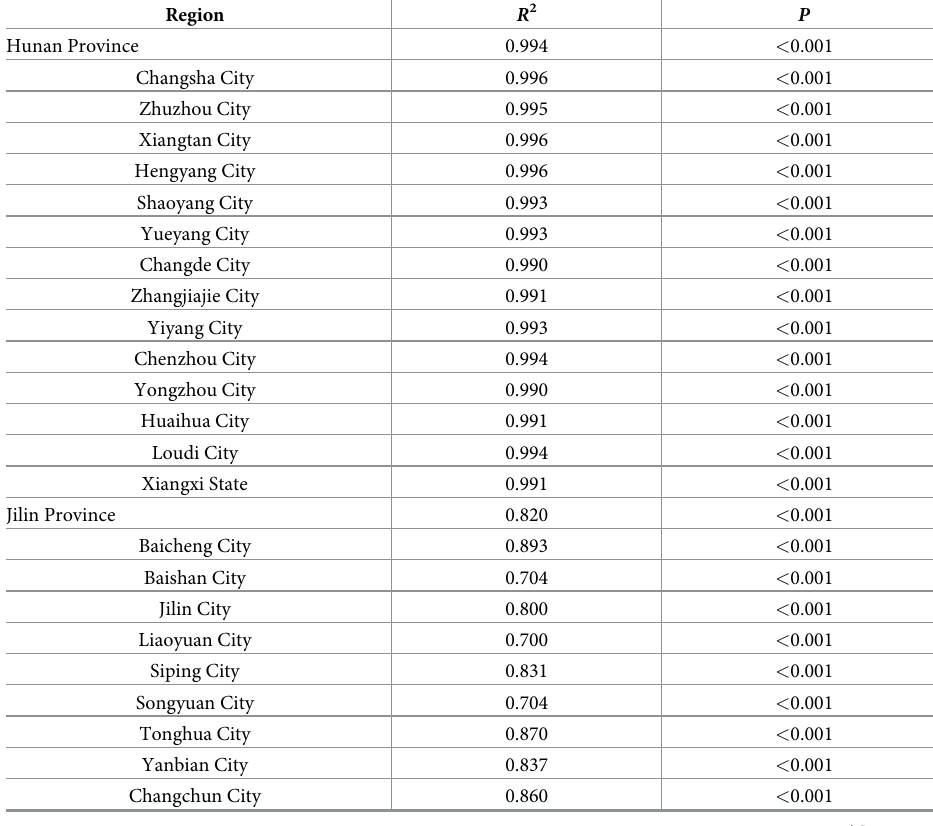
Table 1. Fitting results of LDE model with the selected